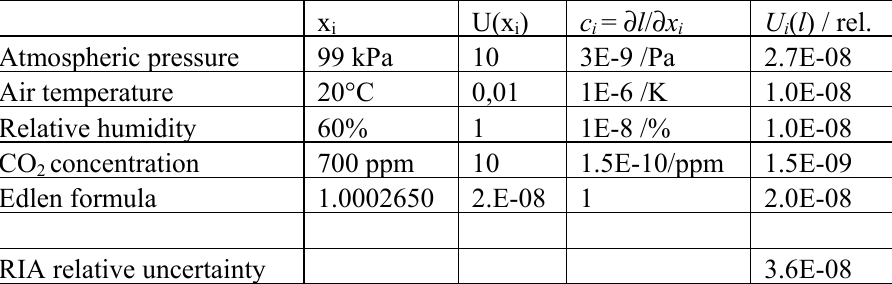
Table 1. Refractive index of air—standard